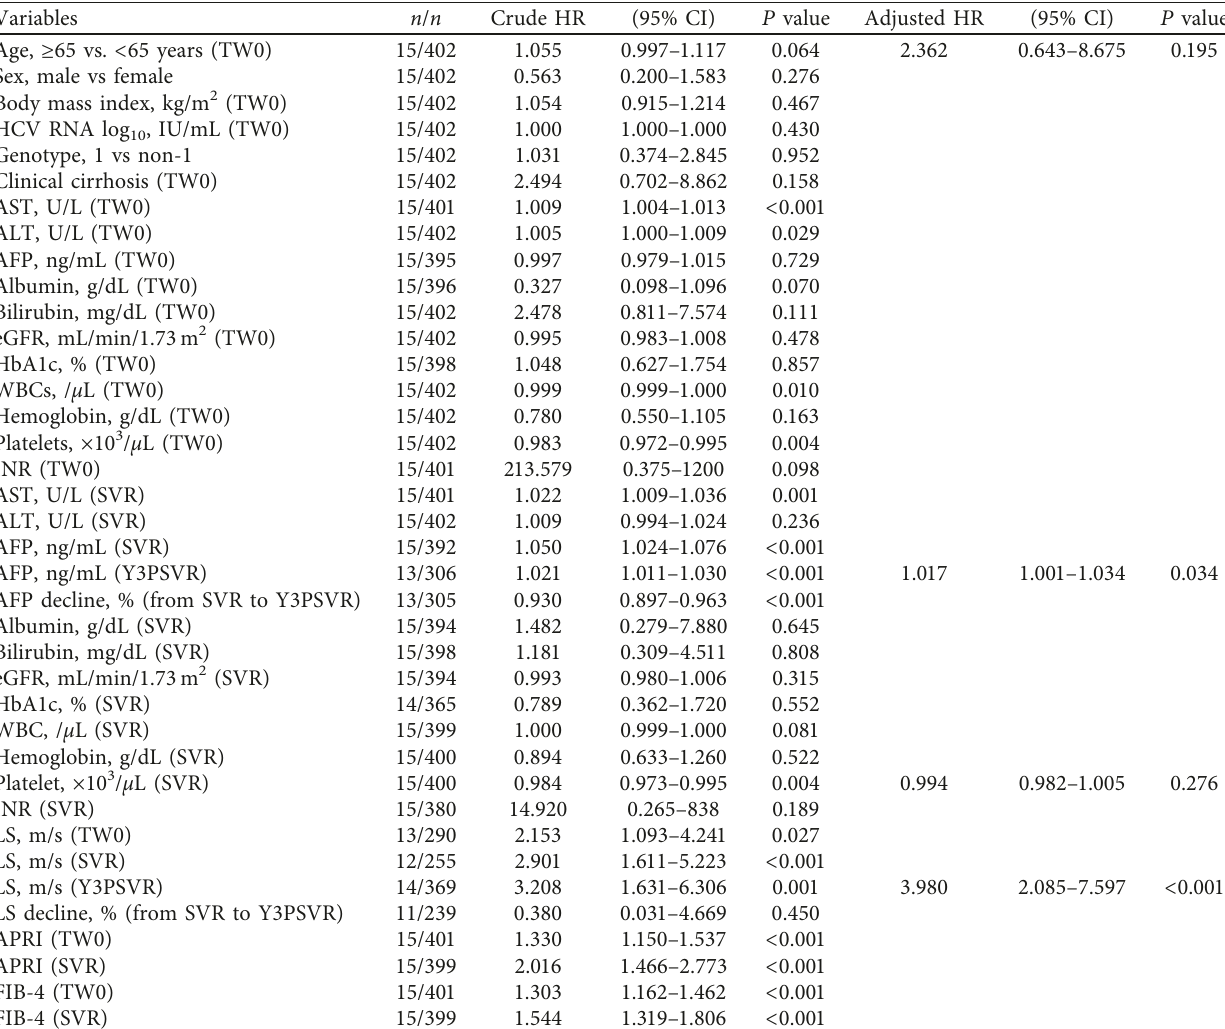
Table 4: Cox regression analysis for prediction of LREs ( n � 12, multivariate analysis) after year 3 post-SVR. Variables